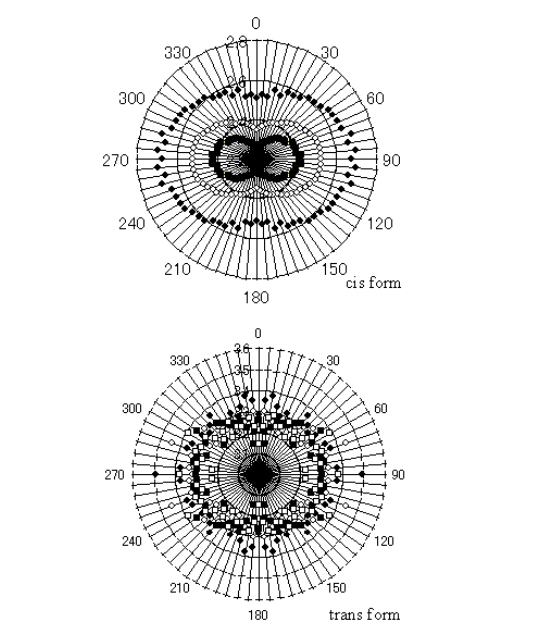
Figure 9. Circular diagram for PMMA-AZ n  - ϖ * at 436 nm for [above] cis form (filled circle for UV after 1 cycle, empty circle for UV after 10 cycles, and filled square for UV after 20 cycles), [below] trans form (filled circle for initial, empty circle for visible after 1 cycle, filled square for visible after 10 cycles, and empty square for visible after 20 cycles).